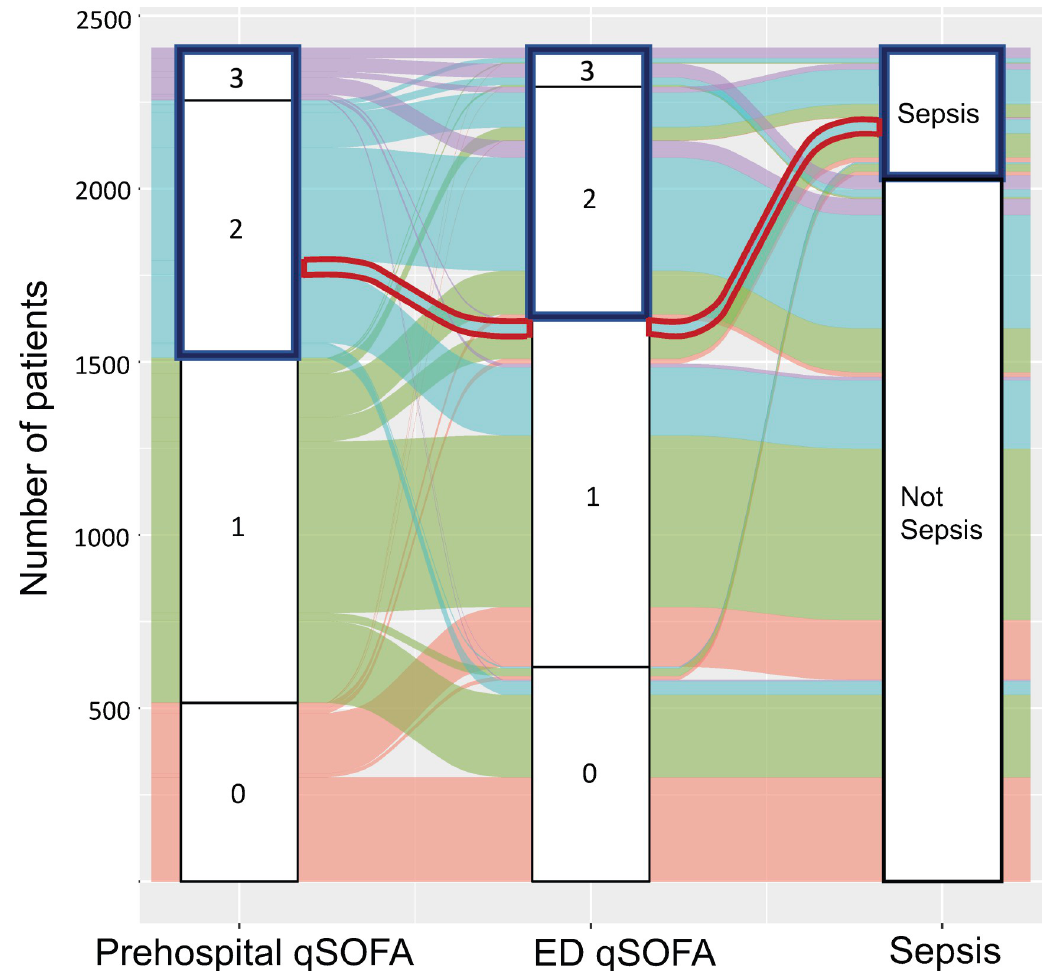
Fig 3. Alluvial plot of changes in prehospital and ED qSOFA scores and the diagnosis of sepsis among patients with clinically suspected infection. This alluvial plot illustrates the changes in qSOFA scores from prehospital to ED arrival and the diagnoses of sepsis based on the Sepsis-3 criteria among patients with clinically suspected infection. As represented by the area in red, combined qSOFA was able to identify 44 (12%) out of 369 patients who were subsequently diagnosed with sepsis based on the Sepsis-3 criteria, which would have been missed using ED qSOFA alone. Abbreviations: ED, Emergency Department; qSOFA, The quick Sequential Organ Failure